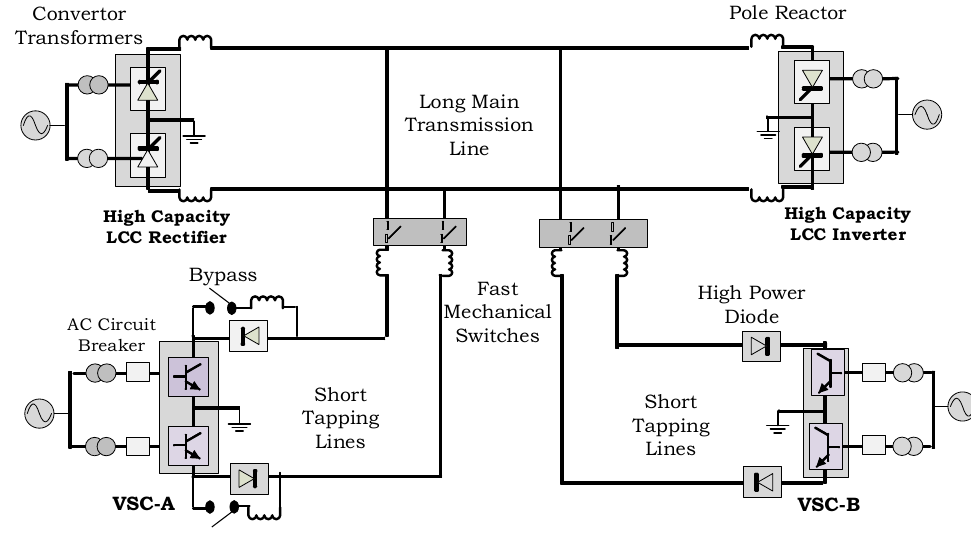
Figure 1. Proposed protection design for hybrid VSC-LCC system in [1].